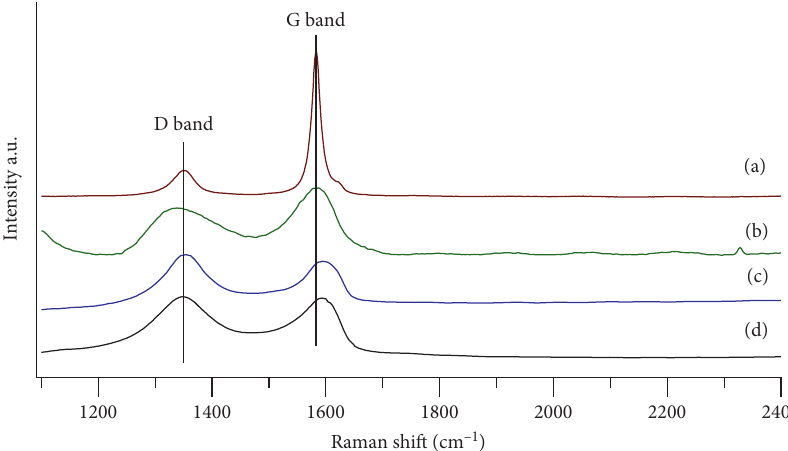
Figure 2: Raman spectra of ExG (a), GO (b), rGO (c), and PtAl/rGO catalyst (d).